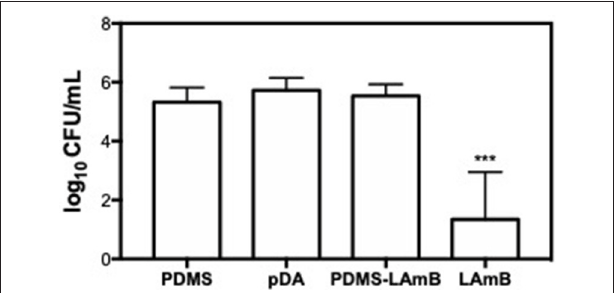
FIGURE 4 | Number of adhered C. albicans cells after exposure to bare polydimethylsiloxane (PDMS), pDA-coated PDMS surfaces (pDA), PDMS after adsorption of LAmB (PDMS-LAmB) and pDA surfaces functionalized with LAmB (Lamb) for 1h, followed by 23h incubation in artificial urine. Significant differences were found for *** p < 0.001 compared to PDMS control samples.